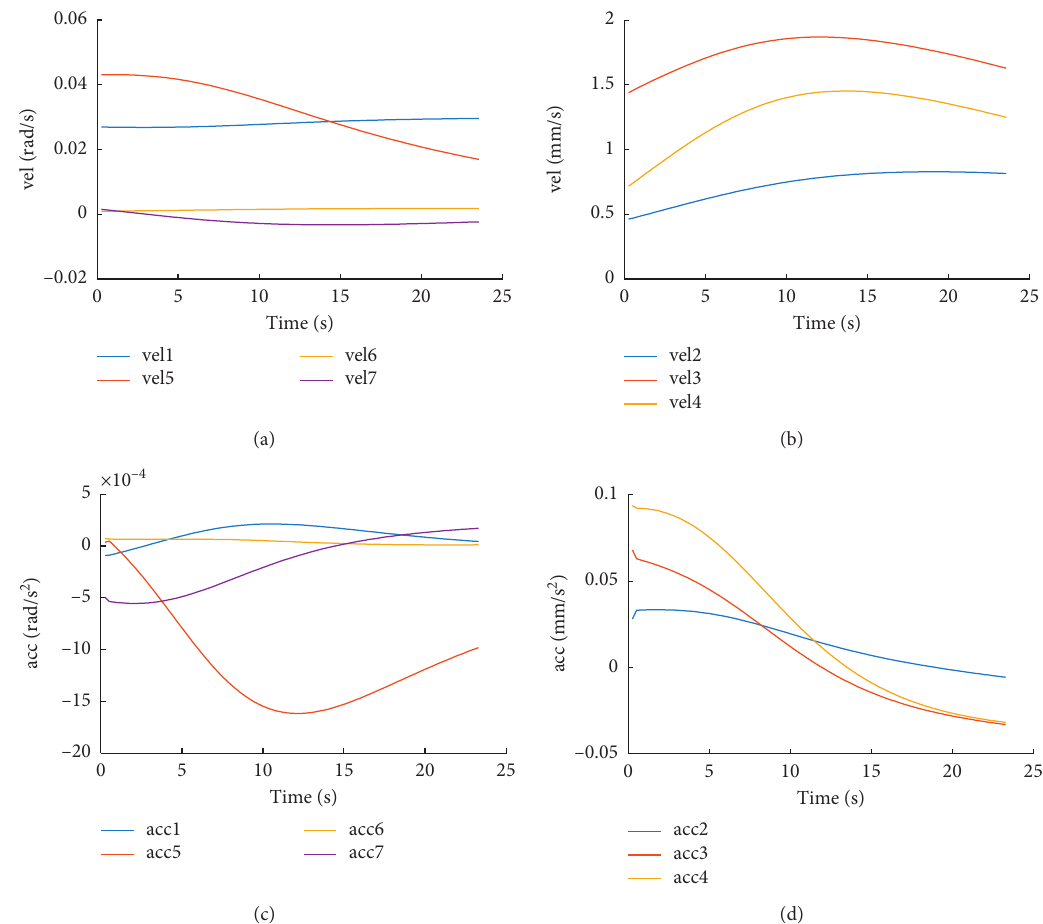
Figure 8: The angular velocity and angular acceleration curves of the first manipulator when Z � 1000. vel1–vel7 represent the velocity of joints 1–7, respectively. acc1–acc7 represent the acceleration of joints 1–7,